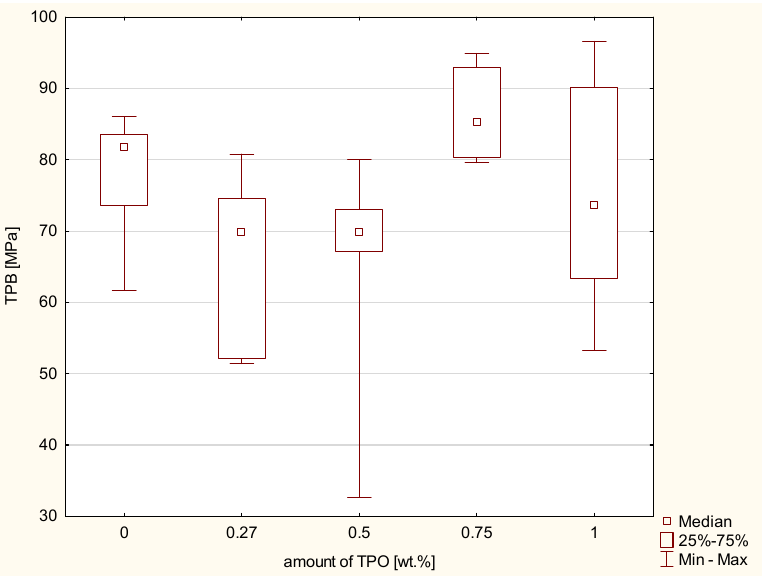
Figure 3. Box-and-whisker plot of three-point bending flexural strength (FS) of experimental com- posites containing different concentration of TPO and the control group CQ and DMAEMA; photo- polymerization both side of samples 20 s per 2 mm thickness of composites with Valo lamp light intensity 1450 mW/cm 2 .